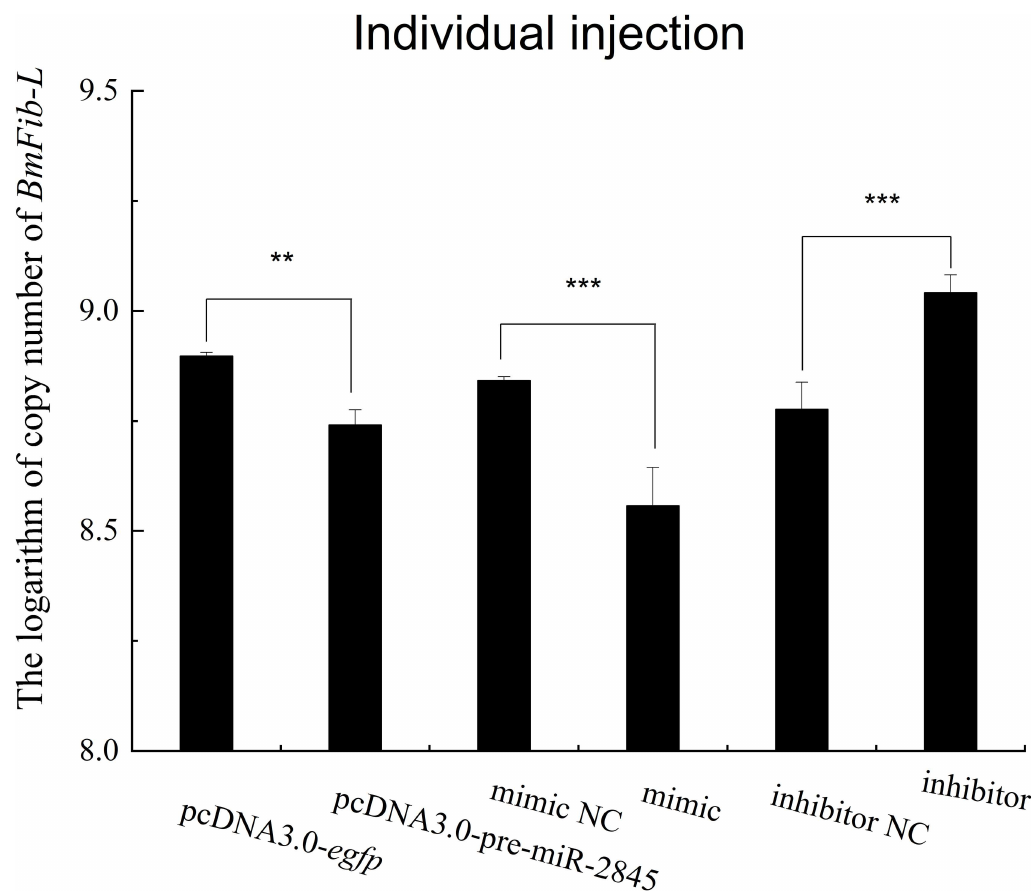
Fig 6. Effects of overexpression and inhibition of bmo-miR-2845 on the expression levels of BmFib-L in B . mori larvae.